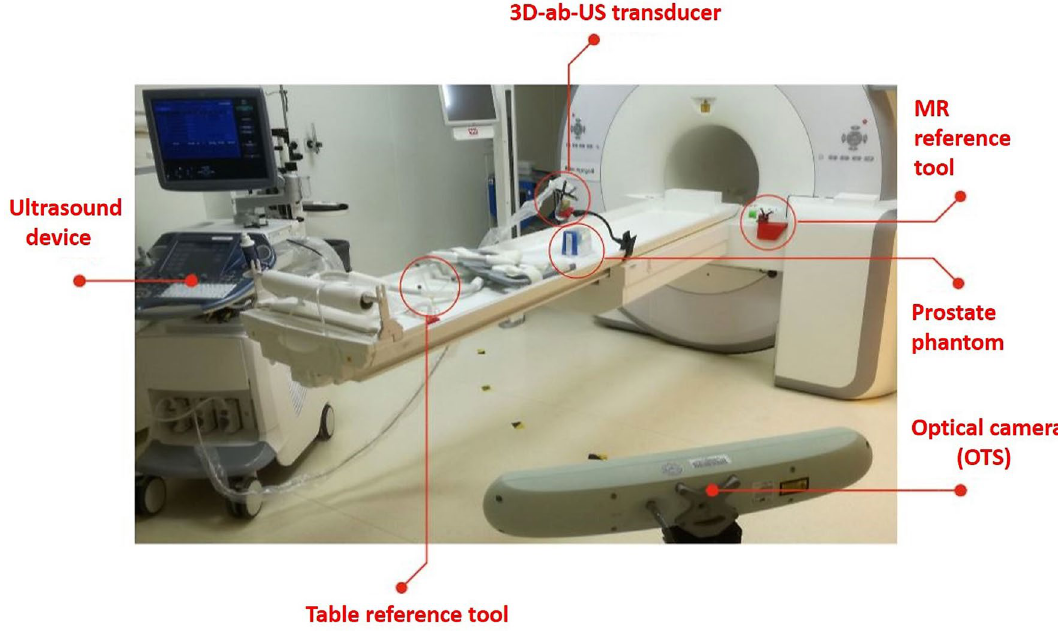
Figure 4. The principle set-up of the system. The phantom (the patient, respectively) is imaged with the ab-3D-US and then with the MR. US images can be linked with the MR using tracker data and US and MR calibrations. During intervention the 3D TRUS image of the phantom will be taken and a 3D-US/3D-TRUS registration augments the image with the MR volume.